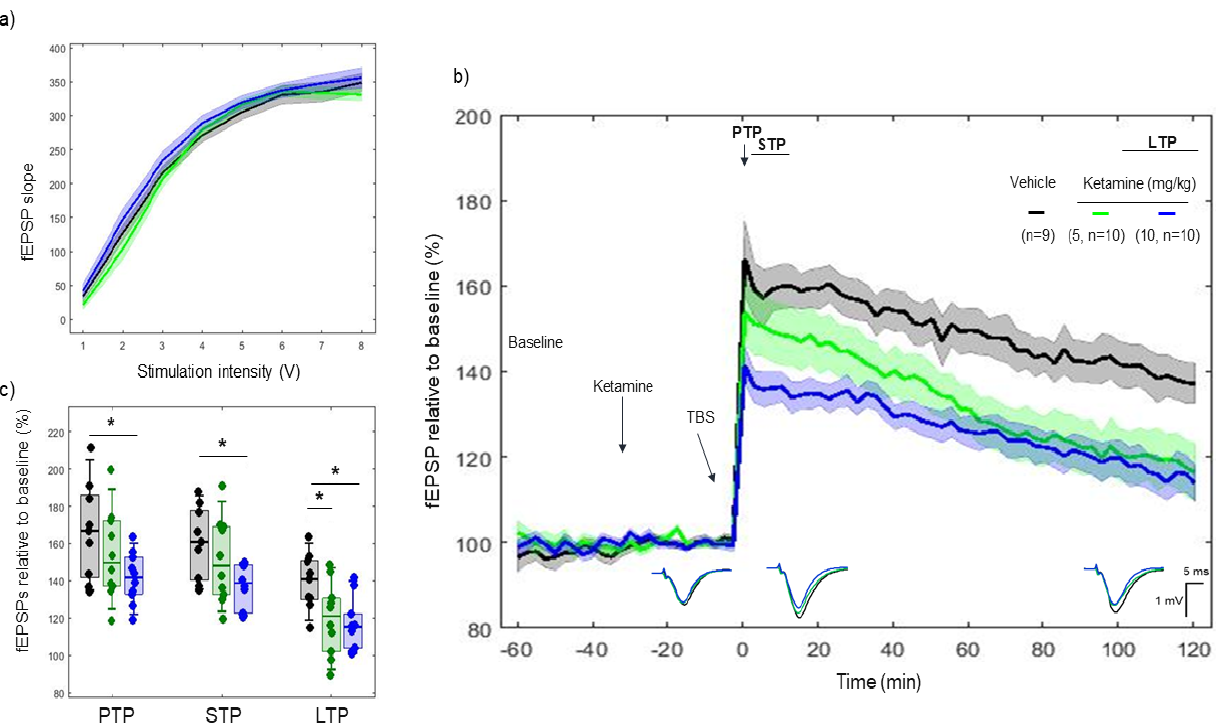
Figure 2. LTP response to ketamine (5 and 10 mg/kg). Ketamine consistently reduced the TBS-induced LTP response for both doses of 5 and 10 mg/kg. ( a ) Collective input/output curves of stimulation voltage and fEPSP slope overlap and no difference is observed in basal synaptic excitability prior treatment with ketamine. ( b ) Basal fEPSPs before tetanization were considered indifferent while after tetanization, the LTP responses of ketamine-treated animals for both doses (green, n = 10; blue n = 10) were lower than the LTP responses in the control group (black, n = 9). Values represent mean ± 95% confidence intervals. Outsets under the LTP curves represent average waveform field potentials during 30 min baseline prior to tetanization, 0–30 min after tetanization and 90–120 min after tetanization. Horizontal bar: 1 mV, vertical bar: 5 ms. ( c ) PTP, STP and LTP responses boxplots, * p < 0.05.